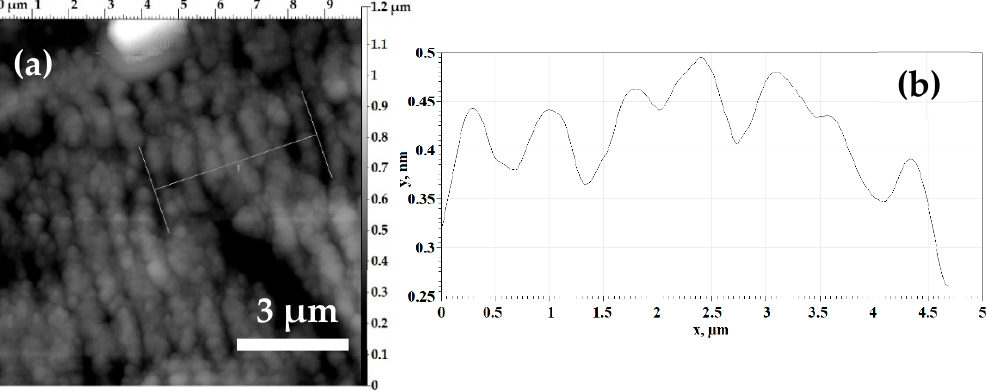
Figure 7. AFM profiling of LIPSS for 5 J / cm 2 with three scan repetitions: ( a ) topography image of a 10 × 10 µ m 2 area; ( b ) linear profile along a direction perpendicular to the LIPSS (dashed line).